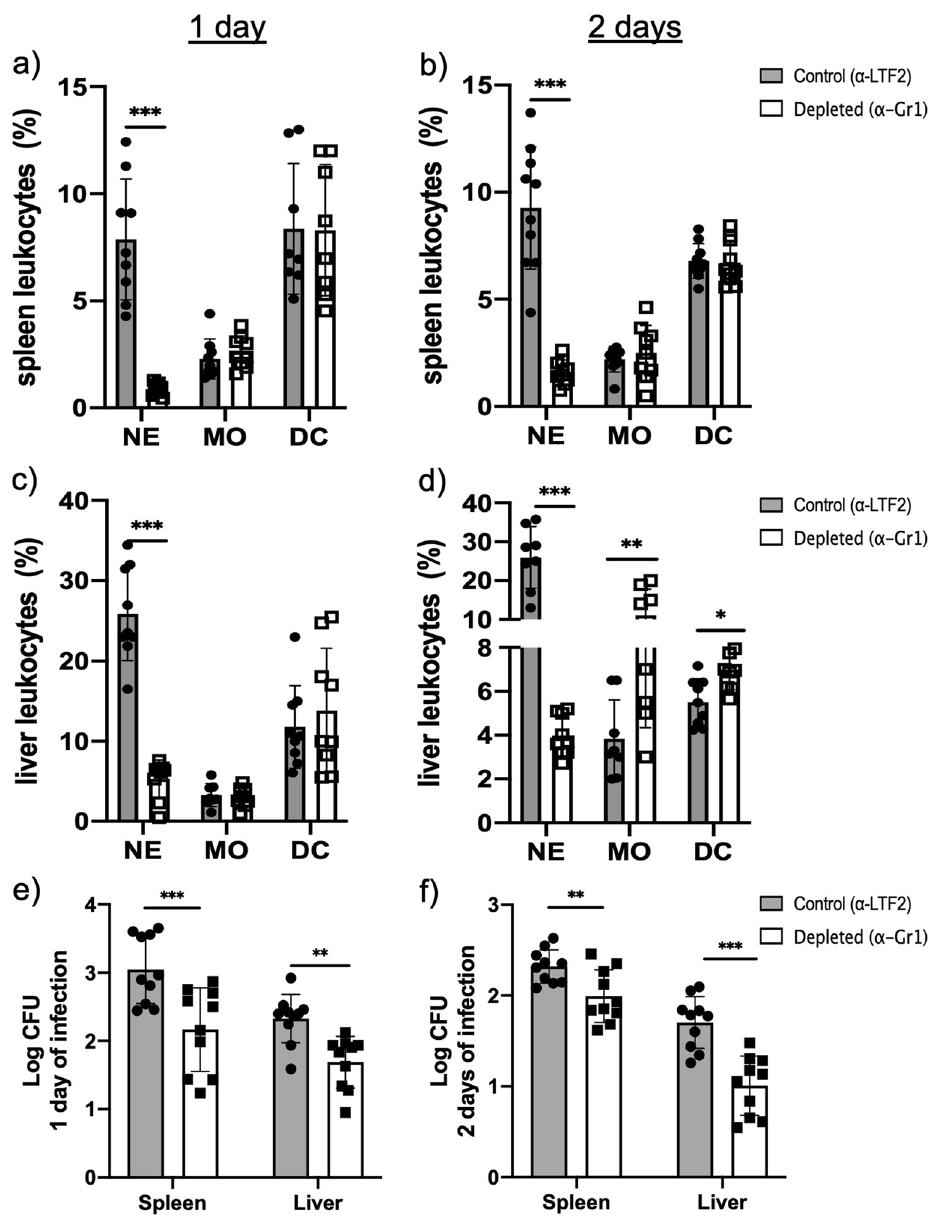
Figure 2. Leukocytes and fungal burden in the spleen and liver of isotype control and neutropenic animals infected with F. pedrosoi : Severe neutrophil depletion was observed after 1 day ( a , c ) and 2 days ( b , d ) of infection in animals treated with α-Gr1. An increase in the macrophage (MO) and dendritic cell (DC) population was observed in the liver after 2 days of infection ( d ). However, these changes were not observed in the spleen nor the liver after 1 day of infection ( a – c ). A lower fungal load was recovered from the spleen ( e ) and liver ( f ) of neutropenic animals after 1 and 2 days of infection. Results from two independent experiments (n = 4–5 animals per group and experiment) were compiled together. Values are expressed as the mean ± SD. * p < 0.05; ** p < 0.01; *** p < 0.001, two-tailed unpaired Student t